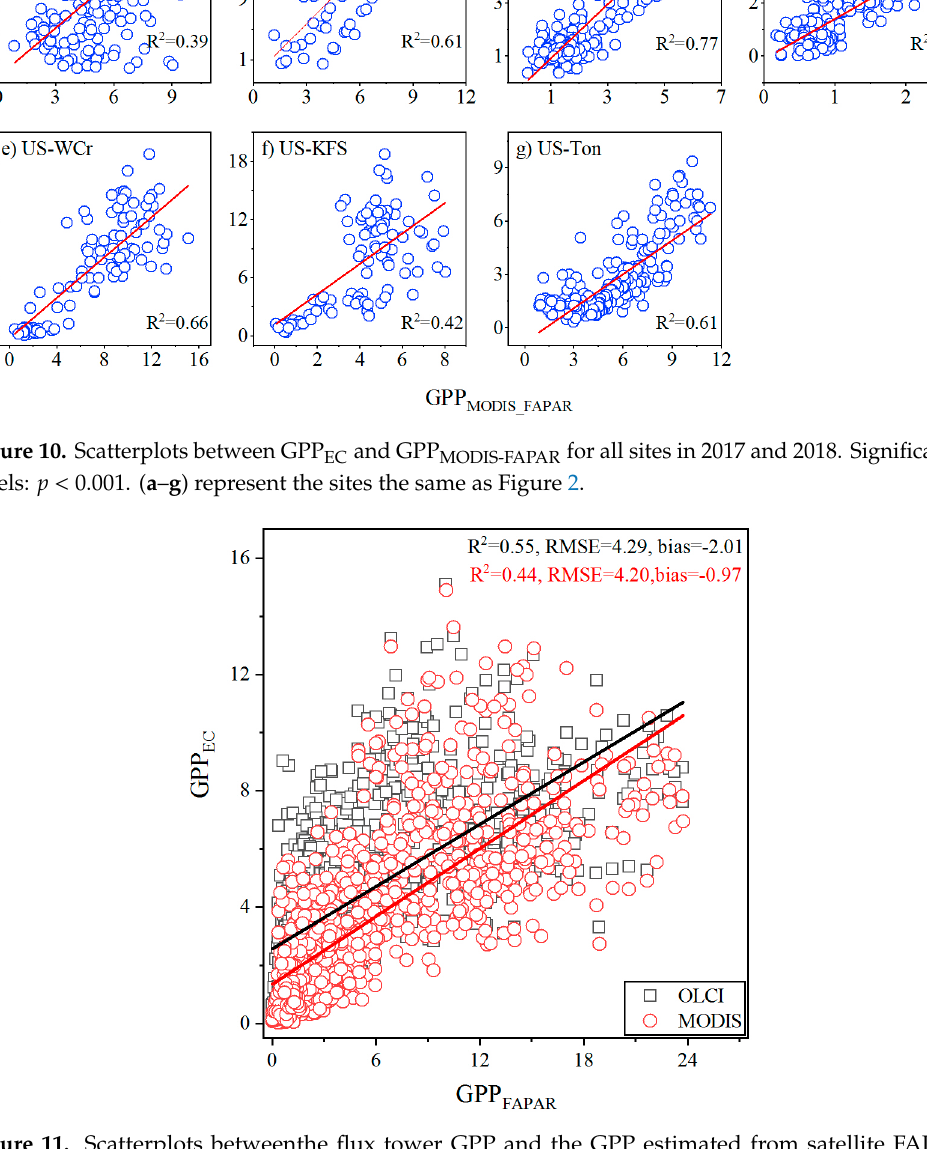
Figure 11. Scatterplots betweenthe flux tower GPP and the GPP estimated from satellite FAPAR products for all combined data across all sites. Black and red lines represent the GPP derived from the OLCI and MODIS FAPAR respectively. Significance levels: p < 0.001.